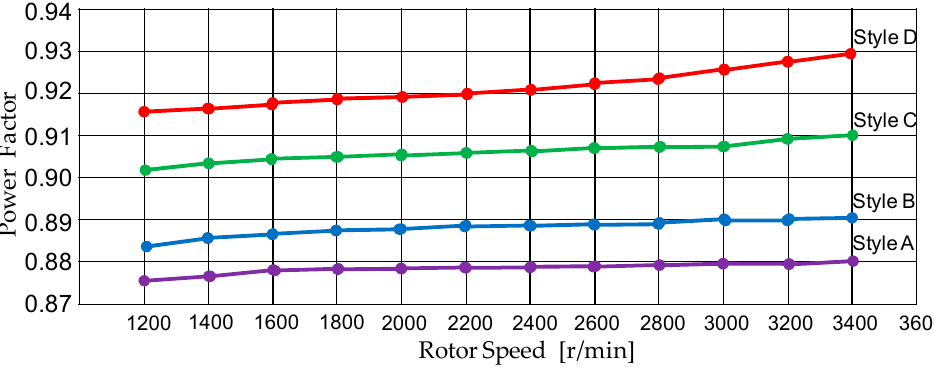
Figure 11. Poly-line graph of power factor for four kinds of SCSCRIMs under several speeds.